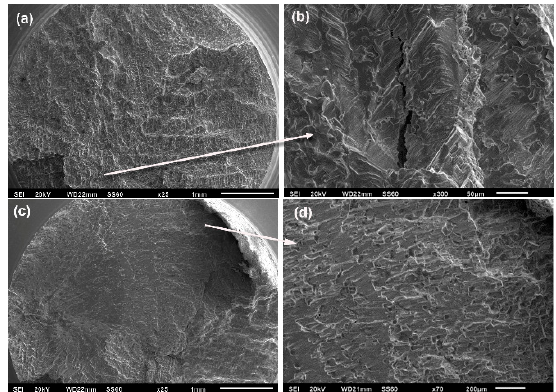
Figure 5. Fracture surfaces in alloys with 0.06 wt % B at 615 MPa: ( a , b ) 0.06B-AC alloy after 51,888 cycles; ( c , d ) 0.06B-HT alloy after 398,440 cycles.